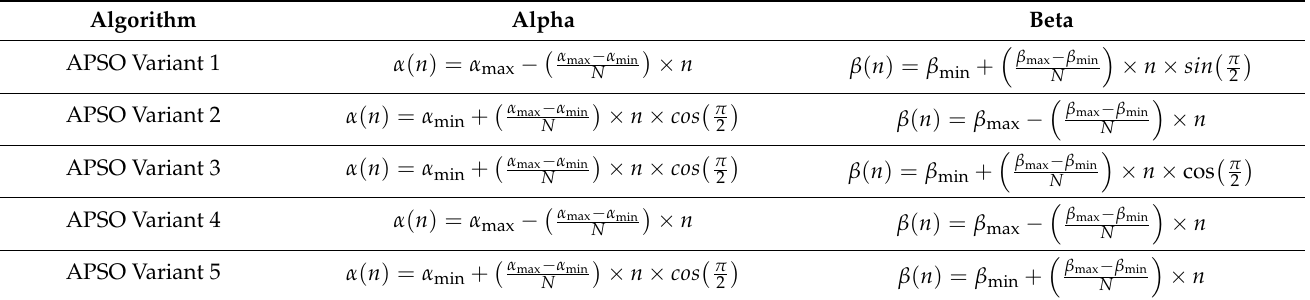
Table 1. Variants of the APSO algorithm